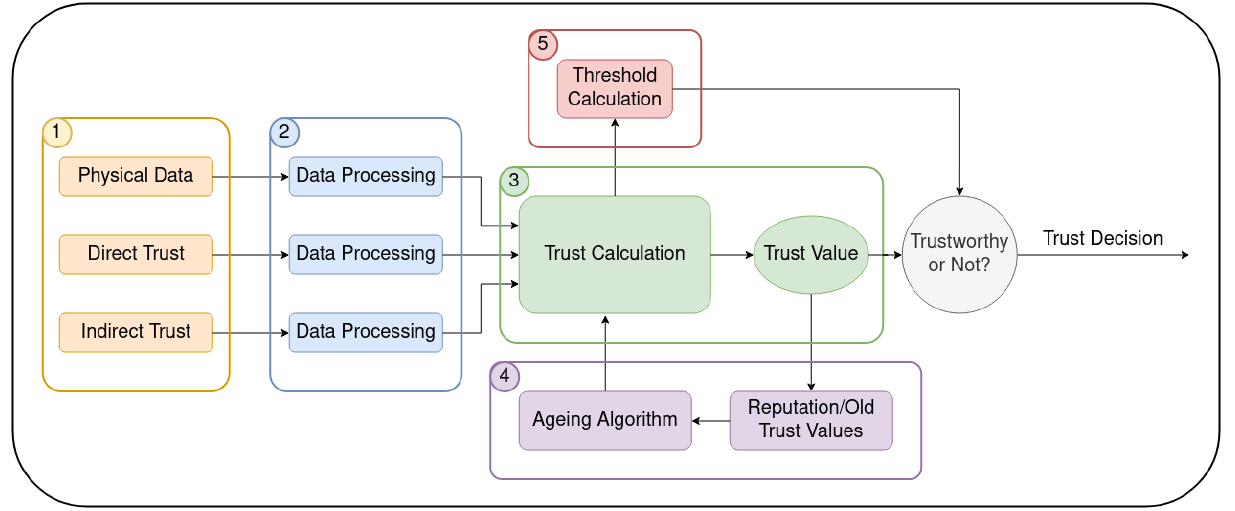
Figure 1. Diagram of a trust model’s basic structure.